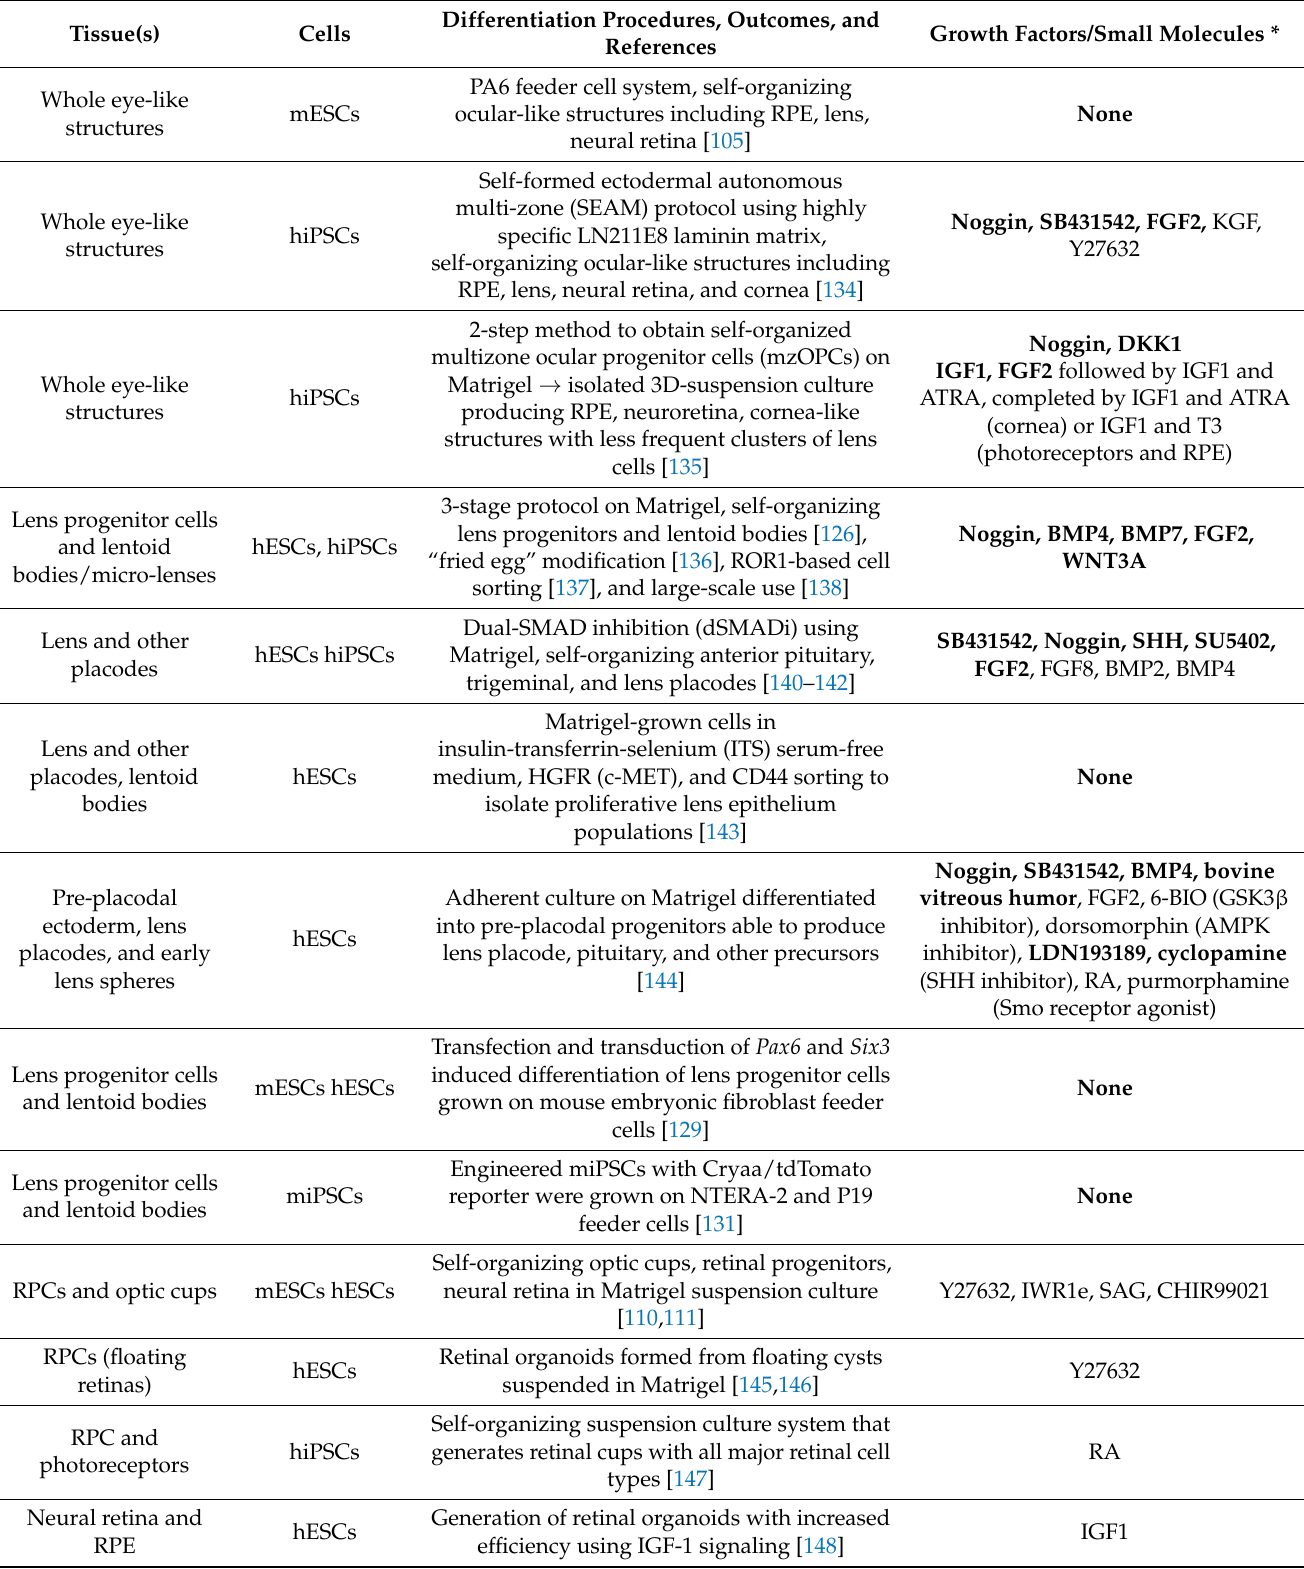
Table 1. A representative list of human ES/iPS differentiation methods to generate the entire spectrum of ocular cell